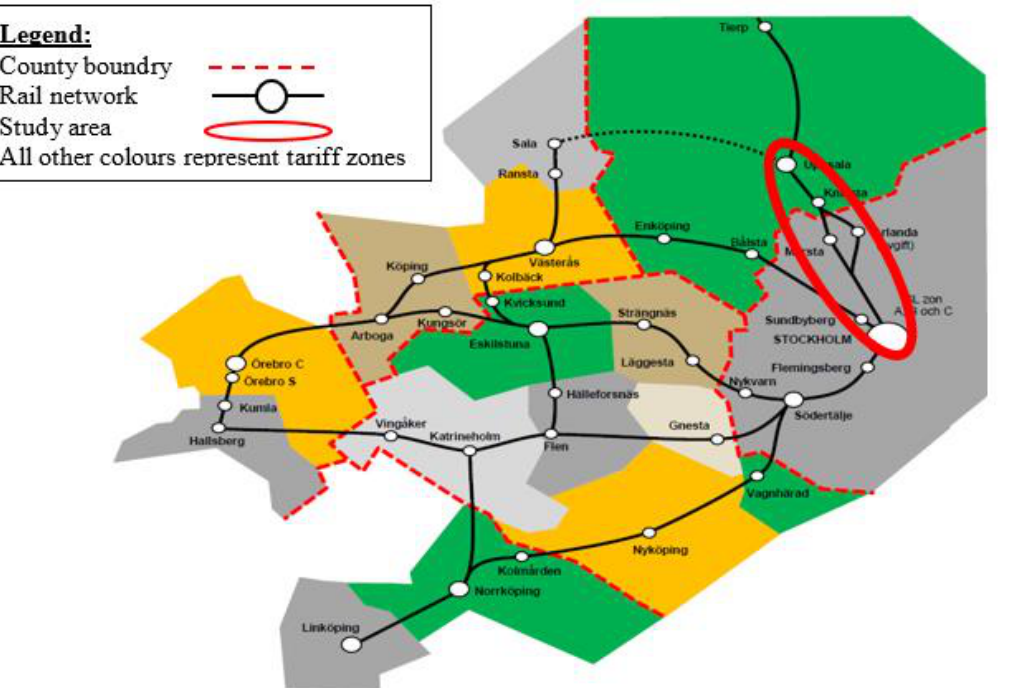
Figure 1: Tariff zones and county boundaries for the Movingo season ticket. Source: Movingo